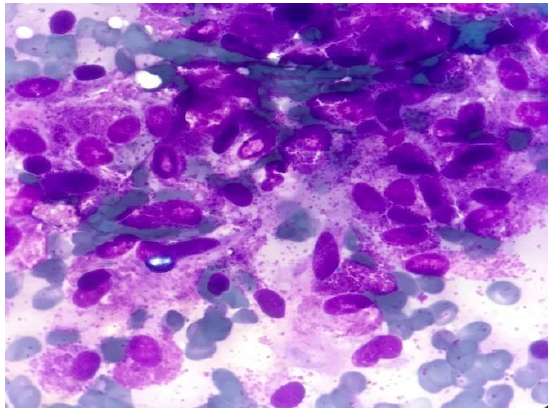
Figure 1. Bone marrow smear showed numerous metachromatic blast cells with vacuolated cytoplasm containing varying numbers of metachromatic granules and spindle-shaped nuclei. (Giemsa, 1000×)